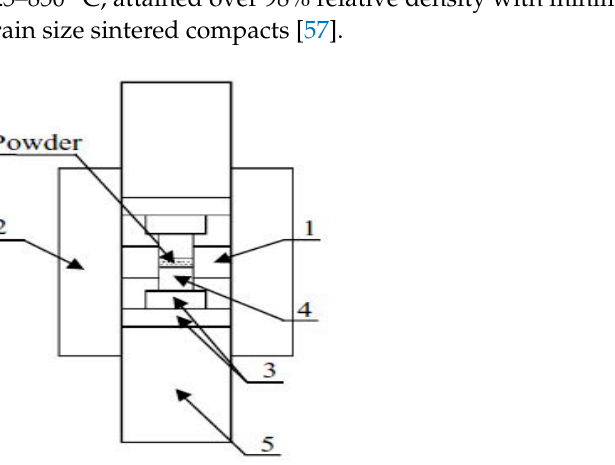
Figure 30. Schematic of high pressure die & punches assembly (1. internal smaller graphite die, 2. outer graphite die, 3. two binderless WC dies, 4. SiC punch plunger, 5. outer graphite punches).